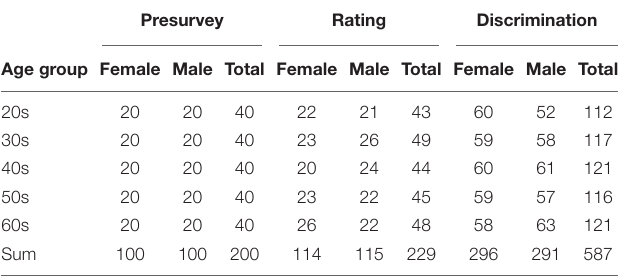
TABLE 1 | Summary of survey